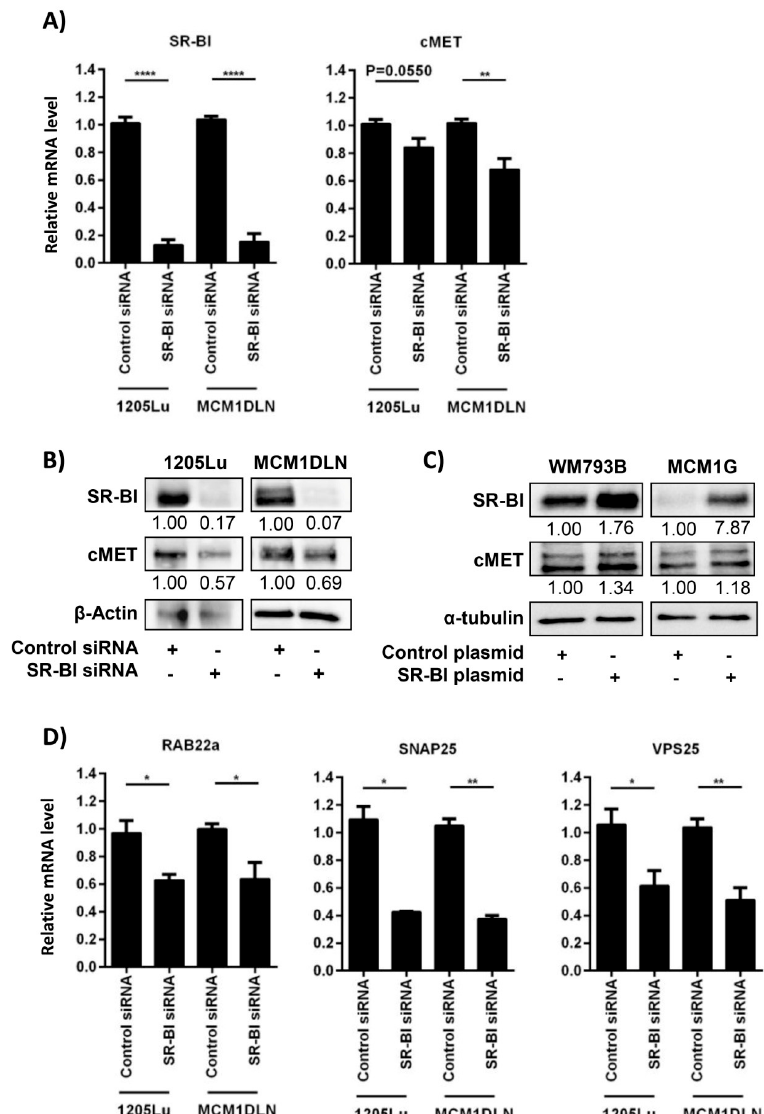
Figure 2. SR-BI depletion reduces the proto-oncogene and vesicle-release-driver cMET. ( A ) mRNA expression of SR-BI (1205Lu **** P < 0.0001, MCM1DLN **** P < 0.0001) and MET (1205Lu P = 0.0550, MCM1DLN ** P = 0.0041) in two human metastatic melanoma cell lines. ( B ) Immunoblotting of SR-BI and MET after SR-BI knockdown of two human metastatic melanoma cell lines. β -ACTIN was used as loading control. ( C ) Immunoblotting of SR-BI and MET after SR-BI over-expression of two primary melanoma cell lines. α -TUBULIN was used as loading control. ( D ) Relative expression levels of RAB22a (1205Lu * P = 0.0131, MCM1DLN * P = 0.0267), SNAP25 (1205Lu * P = 0.0196, MCM1DLN ** P = 0.0068) and VPS25 (1205Lu * P = 0.0305, MCM1DLN ** P = 0.0028) in two human metastatic melanoma cell